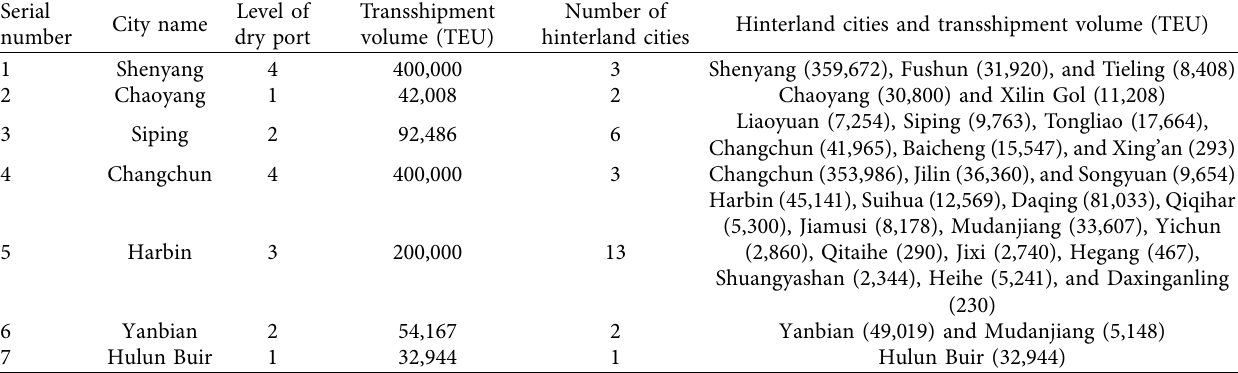
Table 12: Construction of the dry port under the road-rail mode.